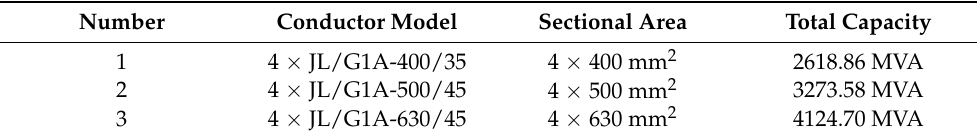
Table 7. Main parameters of optional conductors.